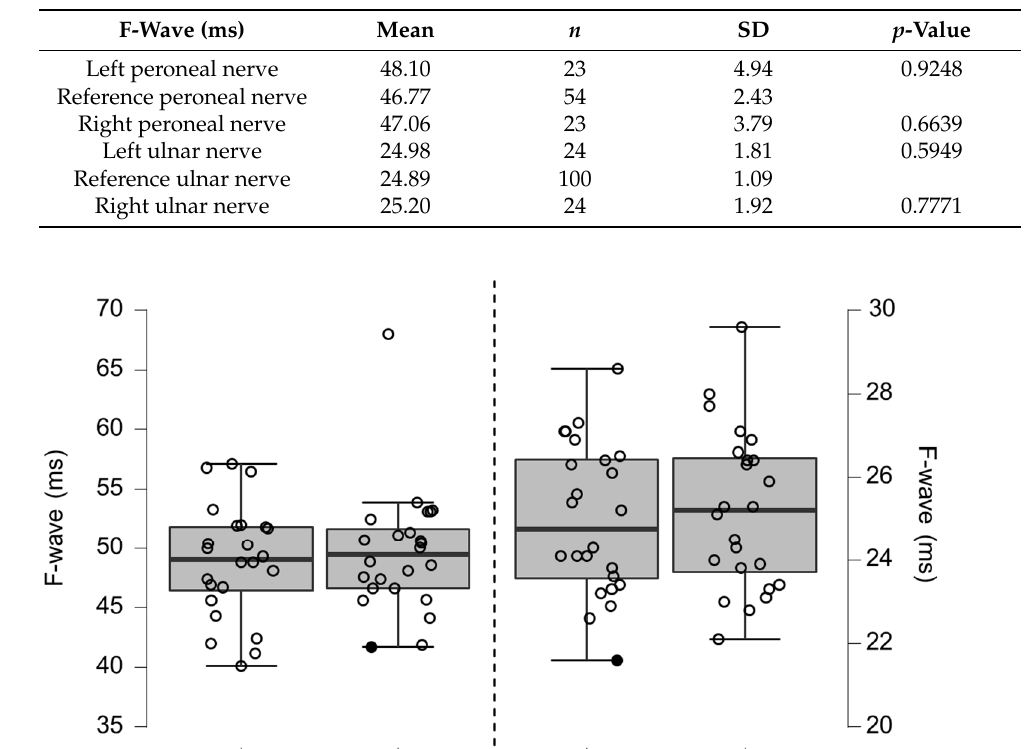
Table 5. Motor neurography F-wave latencies for left and right peroneal and ulnar nerves.